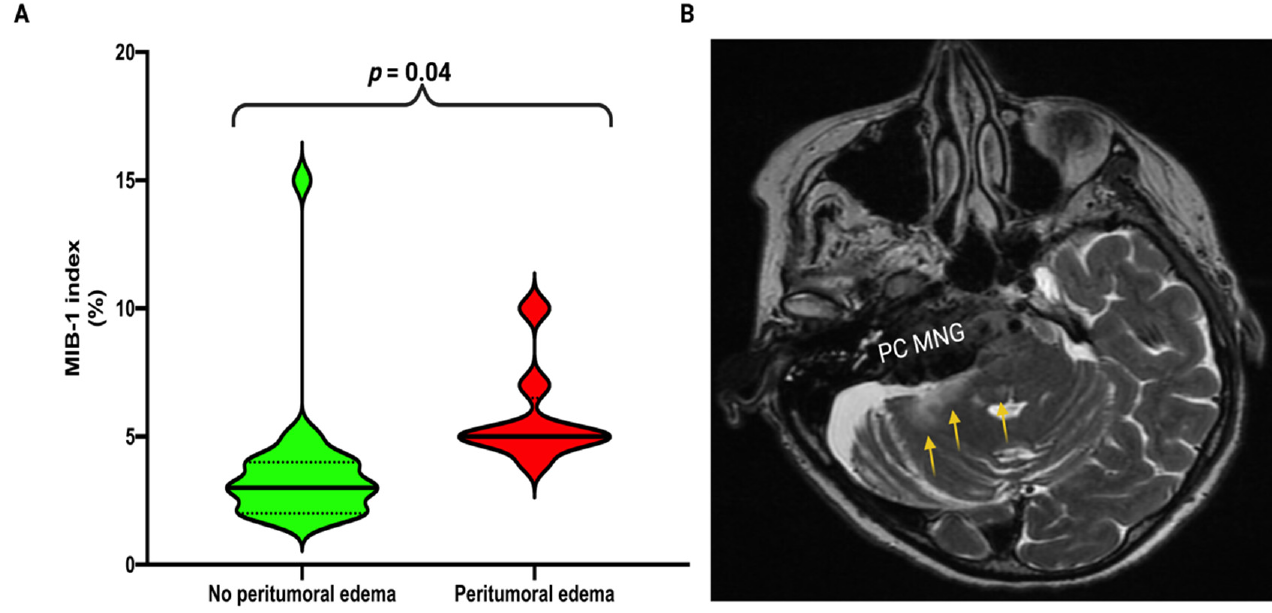
Figure 4. ( A ) Violin-plots displaying MIB-1 labeling index in patients without peritumoral edema (green) and with peritumoral edema (red) Violin plots show mean and distribution of MIB-1 index. Median values are presented by the thick black lines. ( p -values of the Student’s t -test) ( B ) Illustrative image shows a T2-weighted MR-image of a 45-year old woman with a right-sided petroclival meningioma (PC MNG) and a new abducens nerve palsy after PC MNG surgery. The yellow arrows mark the peritumoral edema which is located in the right brachium pontis as well as in the posterior part of the pons which includes the abducens nucleus. Histopathology revealed a MIB-1 index of 7%.